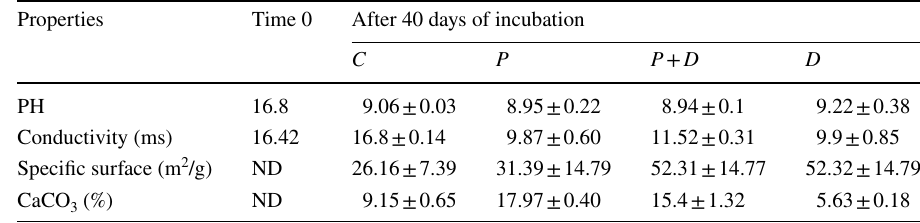
petroleum dispersion on the physicochemical properties of the sediment